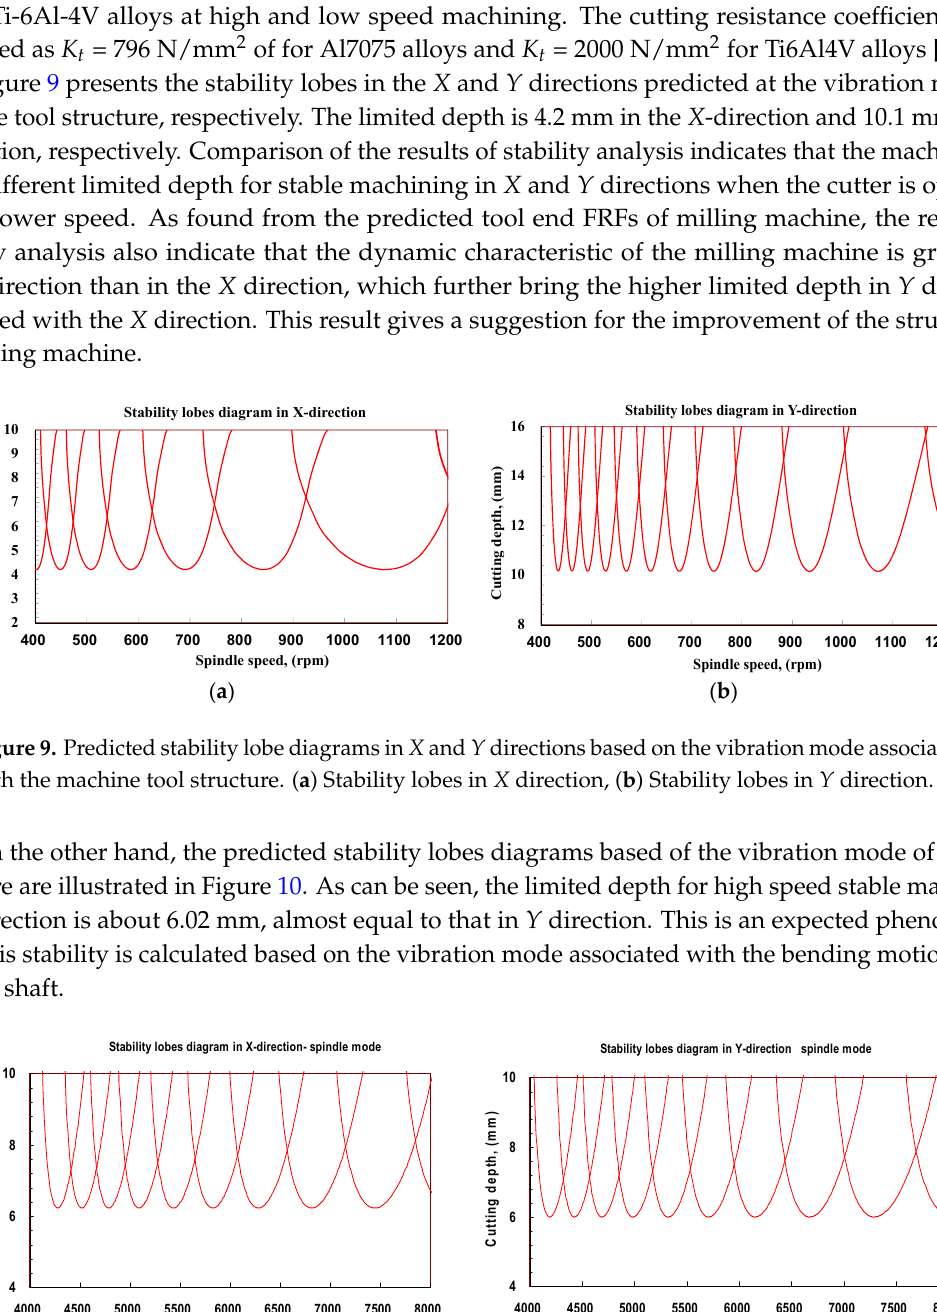
Figure 10. Predicted stability lobe diagrams in X and Y directions based on the vibration mode associated with the spindle structure. ( a ) Stability lobes in X direction, ( b ) Stability lobes in Y direction.